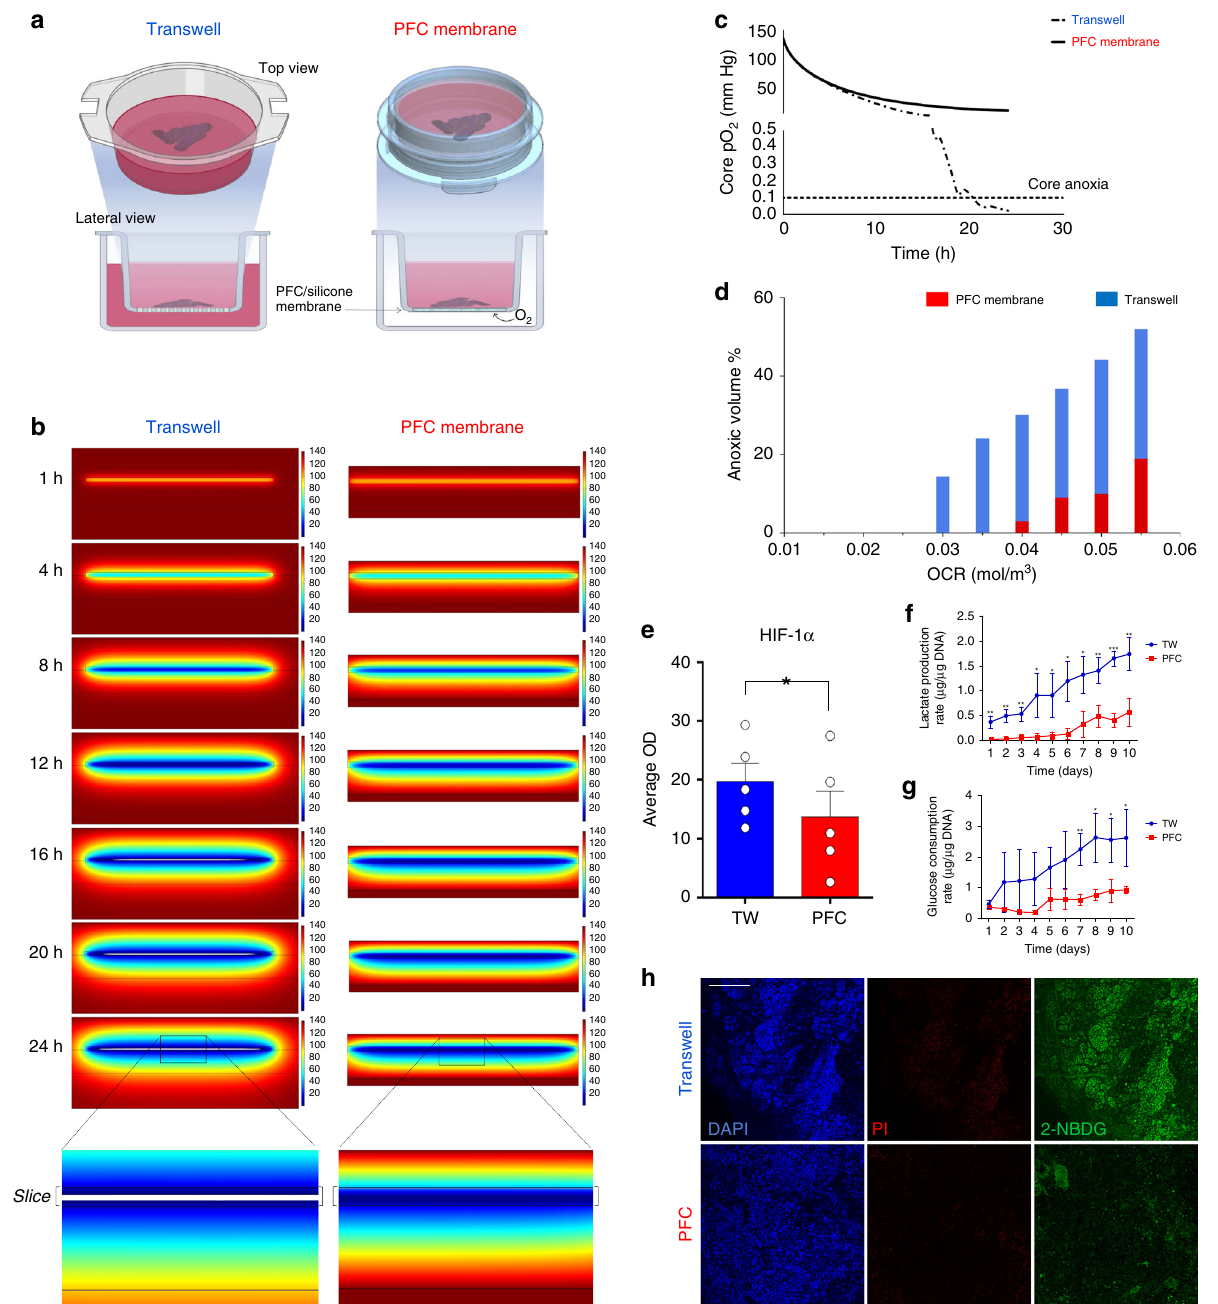
Fig. 1 Enhanced oxygenation of human live pancreatic slices prevents anoxia and preserves oxidative phosphorylation. a Diagram outlining the per fl uorocarbon (PFC) membrane AirHive cell culture dish compared to a transwell dish. PFC dishes are selectively permeable to gases but not liquids. Therefore, medium can be added from the top while air is preferentially transferred directly from the bottom. Graphics partially done with BioRender. b COMSOL modeling of oxygen partial pressure across human pancreatic slices cultured in transwells (left) or PFC membranes (right) over a 24 h period. Spectral scale ranges from high (red) to low (blue) oxygen partial pressure. Anoxic areas are in white. c Partial pressure of oxygen within the core of the slice as a function of time. The dashed threshold represents anoxia. d Total anoxic volume of PFC- (red) and transwell- (blue) cultured slices modeled against increasing oxygen consumption rates. e HIF-1 α protein level determination in transwell- vs. PFC- cultured slices after 24 h of culture ( n = 5 biologically independent samples from individual donors). Two-tailed t -test: * p -value = 0.0304. f Lactate production rate of PFC- (red) and transwell- (blue) cultured slices as a function of time. n = 3 biologically independent samples from individual donors. Multiple two-tailed t -tests: ** p -val 1day = 0.0083, ** p -val 2days = 0.0037, ** p -val 3days = 0.0056, * p -val 4days = 0.0319, * p -val 5days = 0.0357, * p -val 6days = 0.0111, * p -val 7days = 0.0192, ** p -val 8days = 0.0092, *** p -val 9days = 0.0004, *** p -val 10days = 0.0009. g Glucose consumption rates of PFC- (red) and transwell- (blue) cultured slices as a function of time. n = 3 biologically independent samples from individual donors. Two-tailed t -tests: ** p -val = 0.0063, * p -val = 0.0167, * p -val = 0.0244, 7day 8days 9days * p -val 9days = 0.0343. h Representative immunostaining of 2-NBDG uptake (green) during a 10-min incubation of human pancreatic slices cultured in transwells (top) or PFC dishes (bottom), re fl ecting the higher relative uptake of glucose of the former. Red: Propidium Iodide (PI), indicative of cell death. Blue: DAPI. Scale: 100 μ m. b – d represent theoretical computational modeling and have no error bars. In e , data are presented as mean ± S.E.M; in f , g , as mean ± SD. Each n further represents the mean of three technical replicates. Source are provided in the Source Data fi